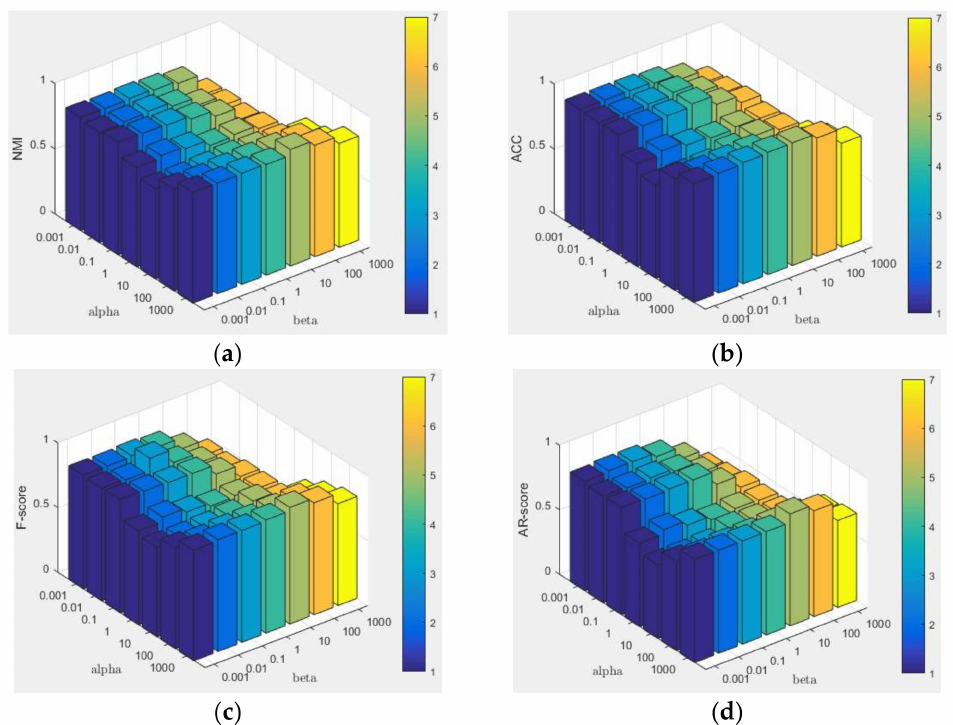
Figure A4. Sensitivity test on alpha and beta versus four metrics on MSRCV1. ( a ) NMI, ( b ) ACC, ( c ) F-score, ( d ) AR.